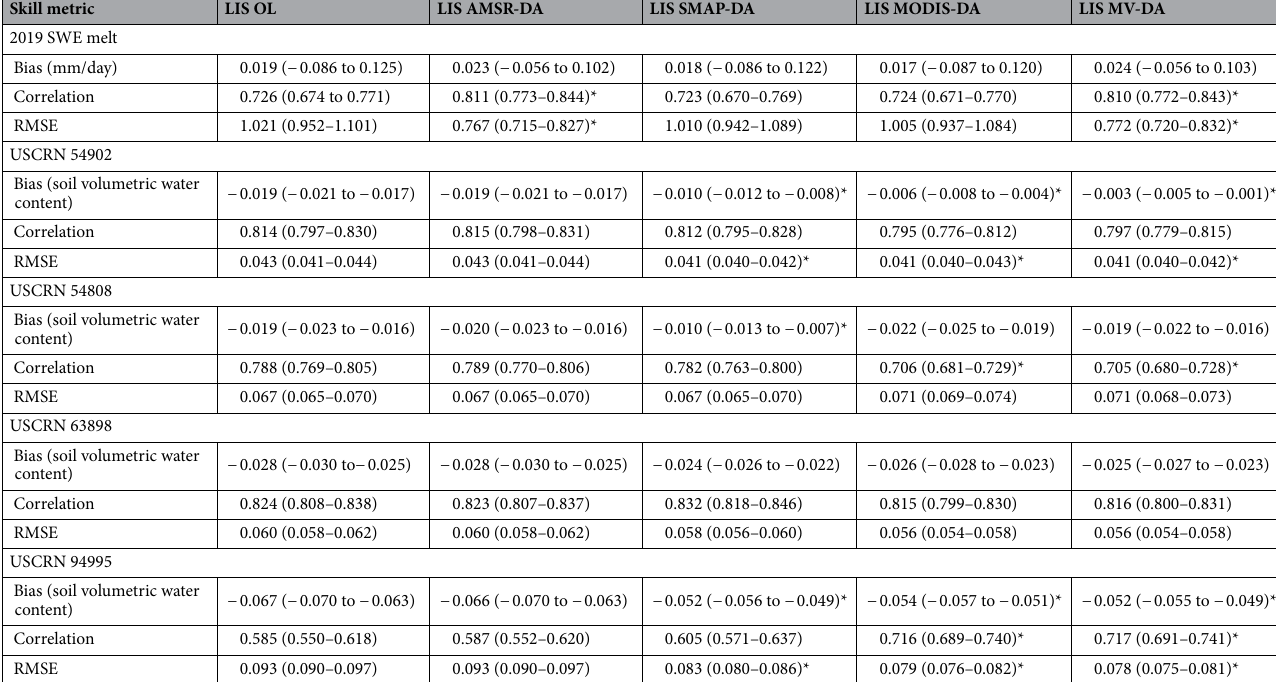
Table 1. Model Skill Compared to Observations. Skill score metrics (bias, correlation coefficient, and RMSE) for modeled 2019 LIS OL, AMSR-DA, SMAP-DA, MODIS-DA, and Multivariate-DA simulated SWE melt over the Corn Belt domain compared to UA SWE melt are plotted in the top rows. July 2015–July 2020 0–10 cm soil moisture from the same LIS simulations compared to 5-cm soil moisture at USCRN sites are listed in the bottom rows. 95% confidence intervals for all metrics are shown. Confidence intervals for bias and RMSE use a student’s t-test and a Chi-Square Distribution, respectively. Confidence intervals for correlation are computed using a Fisher